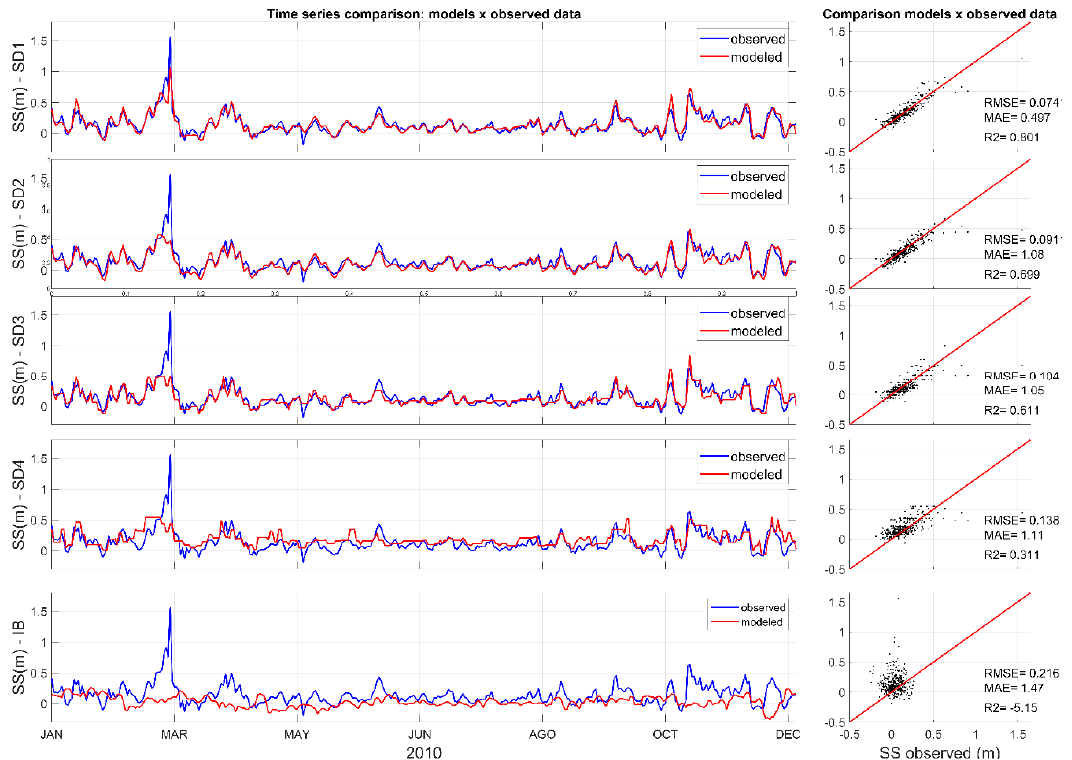
Figure 6. Comparison of the performance of the different downscaling approaches described in Table 2. Validation year: K = 2010.